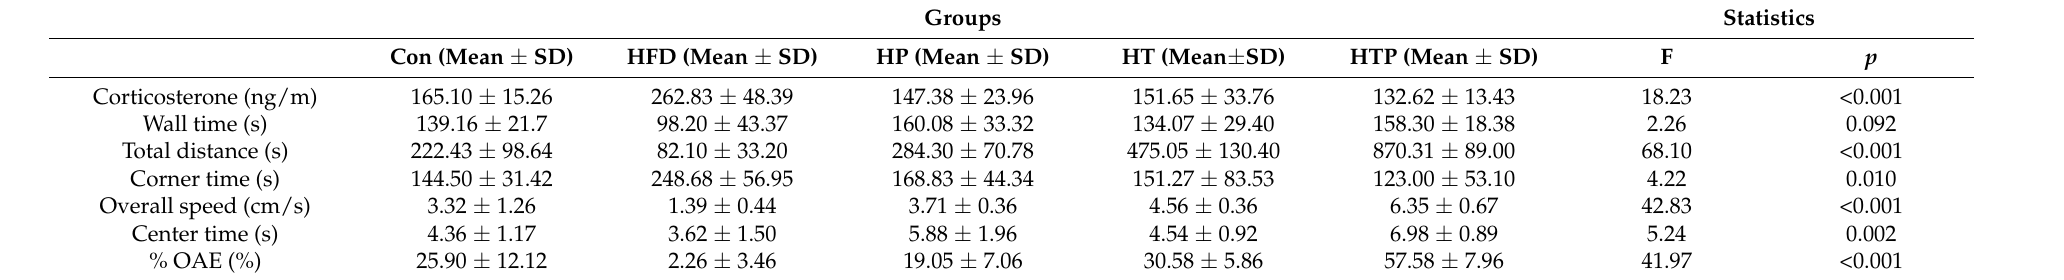
Table 1. Comparison of variables between the groups of study using one way ANOVA